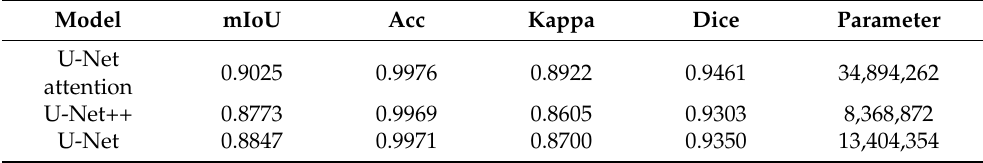
Table 2. Comparison of model segmentation results.